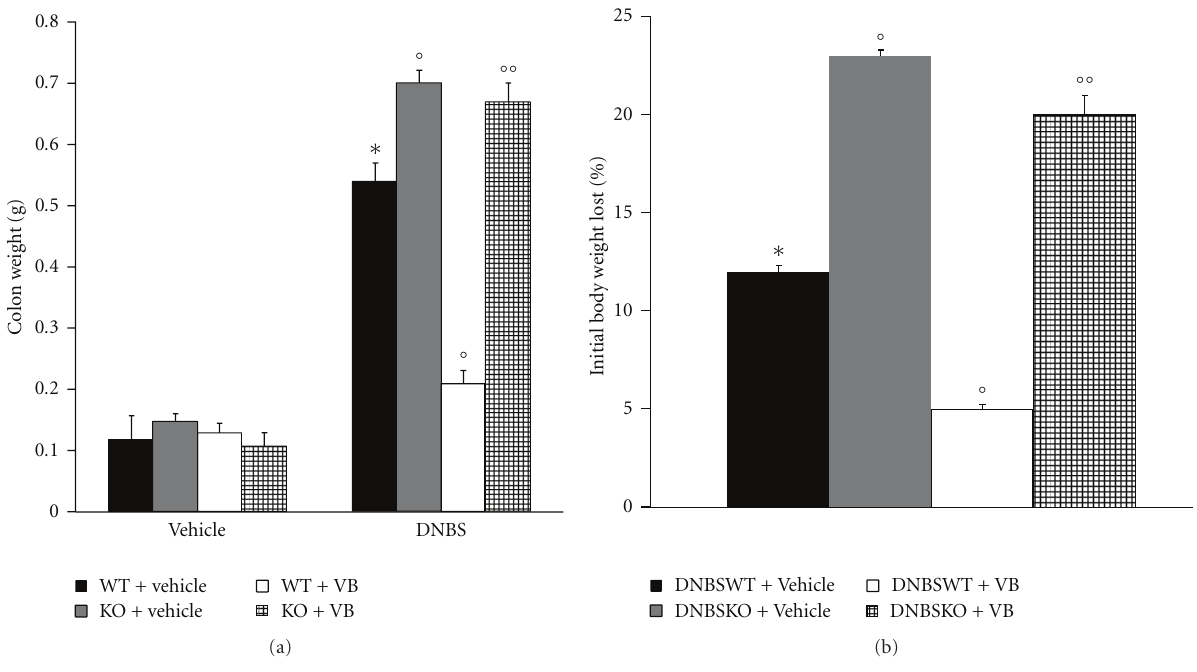
Figure 4: Role of PPAR- α in the anti-inflammatory property of VB on colon weight and body weight lost. Four days after DNBS administration a significant increase in colon weight (a) and body weight lost (b) was observed. Treatment with VB significantly reduced the increased colon weight and lowered body weight lost. The absence of PPAR- α gene significantly abolished the e ff ect of VB. Figure 4 is representative of all the animals in each group. Data are means ± SEM of 10 mice for each group. ∗ P < . 01 versus Sham; ◦ P < . 01 versus DNBS-WT group.